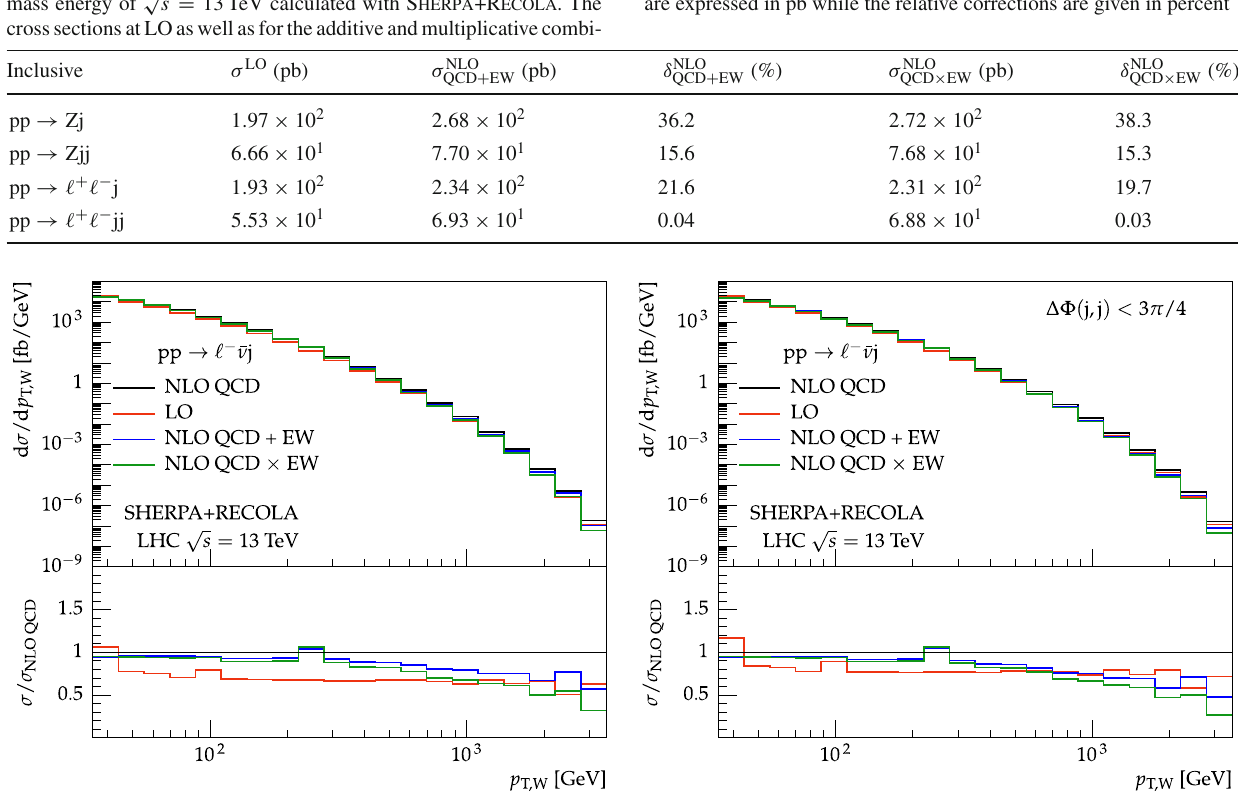
nations of NLO QCD and EW corrections are given. The cross sections are expressed in pb while the relative corrections are given in percent